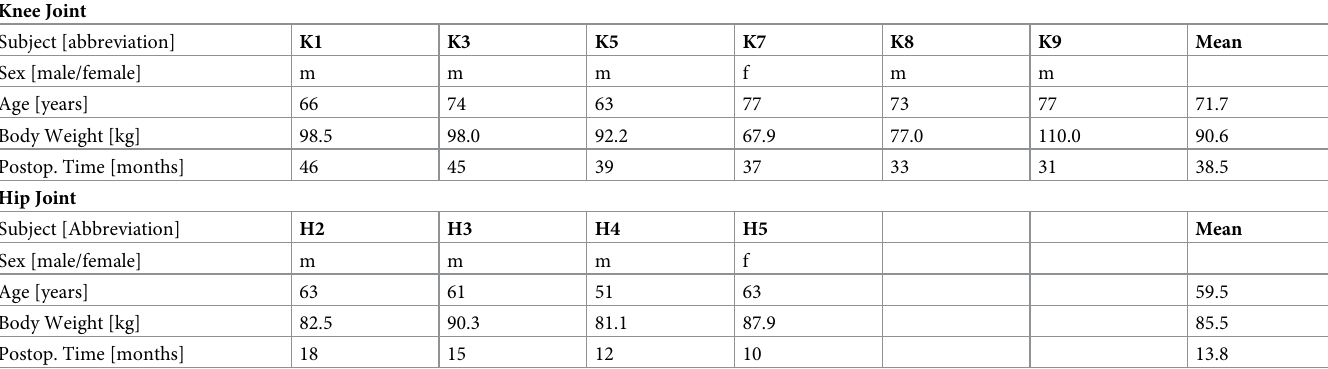
Table 1. Subject data. The measurements at the knee and hip were taken in two different cohorts. Postop. Time = Time of